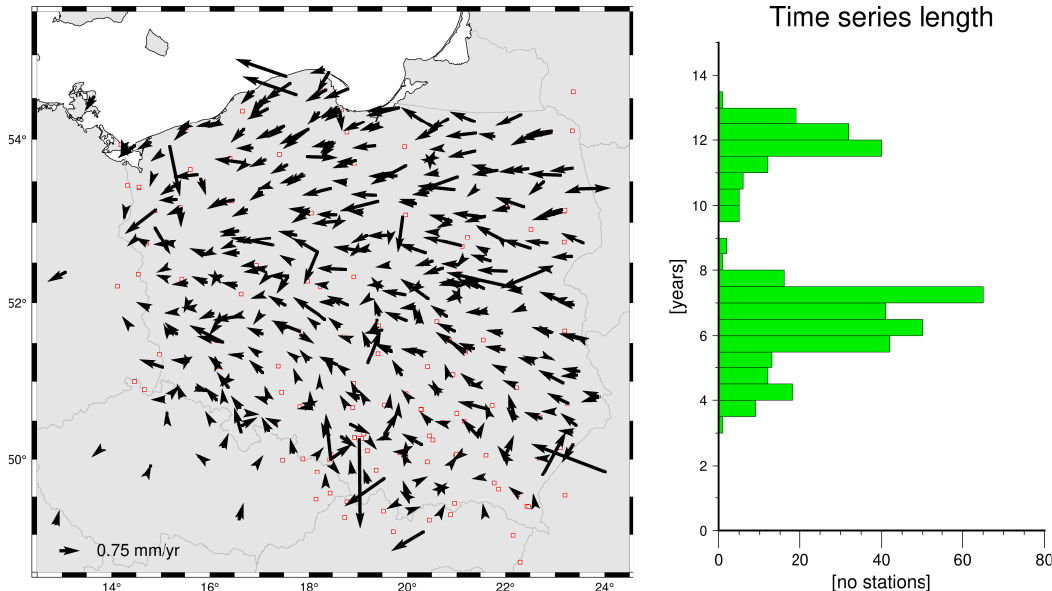
Figure 3. ( Left ): intraplate horizontal velocities (excluded stations marked by red squares). ( Right ): histogram of the time series lengths.